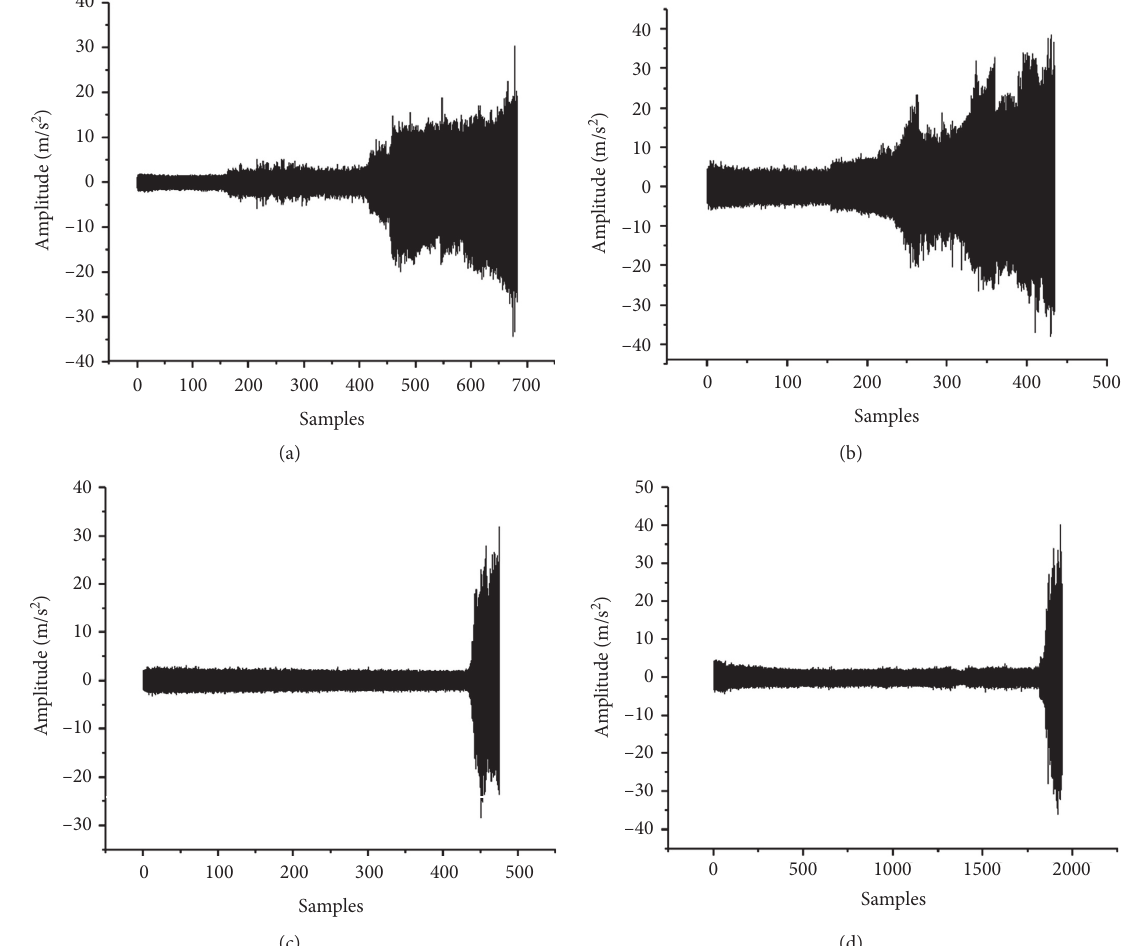
Figure 7: Plot of the original time-domain vibration signal for the full life cycle of a rolling bearing. (a) Bearing2_3. (b) Bearing2_5. (c) Bearing3_3. (d)